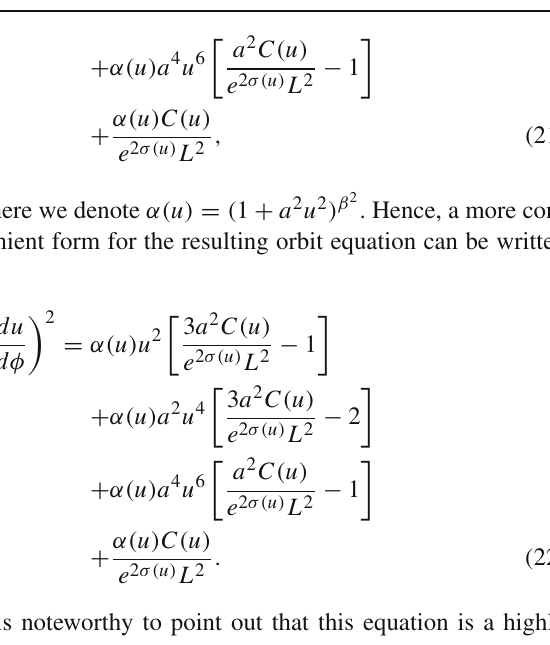
Fig. 1 Pictorialviewoftheoblatecoordinatesintheplane (v,θ) witha hyperboloid and centered ellipsoid. It is shown a reduction of the oblate coordinates into a two dimensional plane with θ = 0. In this case, we have a two dimensional ellipsoid where r → 0 is transformed into a singular ring (in the sense of Riemann invariants are infinite). In the case r → ∞ , the elliptical plane approaches to a circular